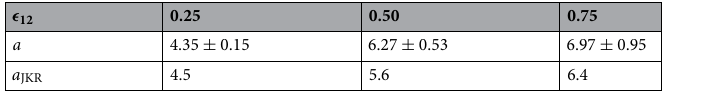
Table 2. Contact radius a , as obtained from our simulations, compared to the JKR prediction, a JKR , Eq. (6). Simulation data are averages over three relaxed